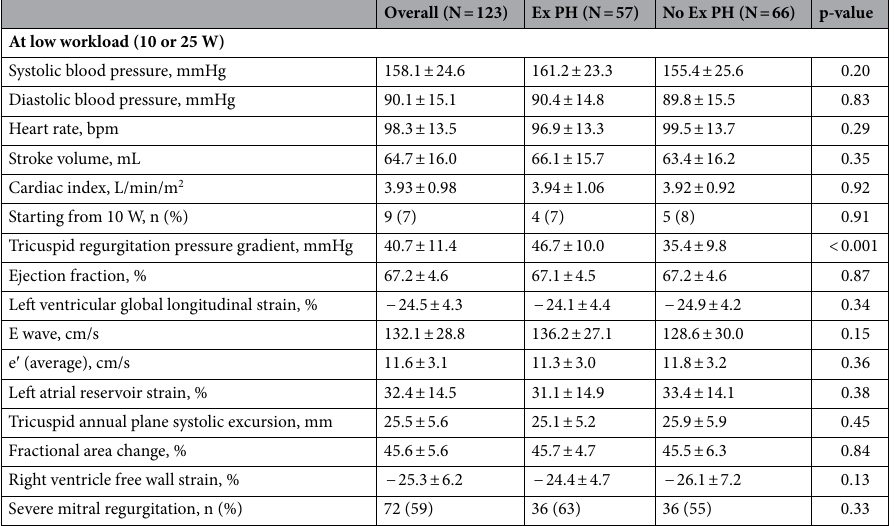
Table 4. Associated parameters at low workload. EIPH exercise-induced pulmonary